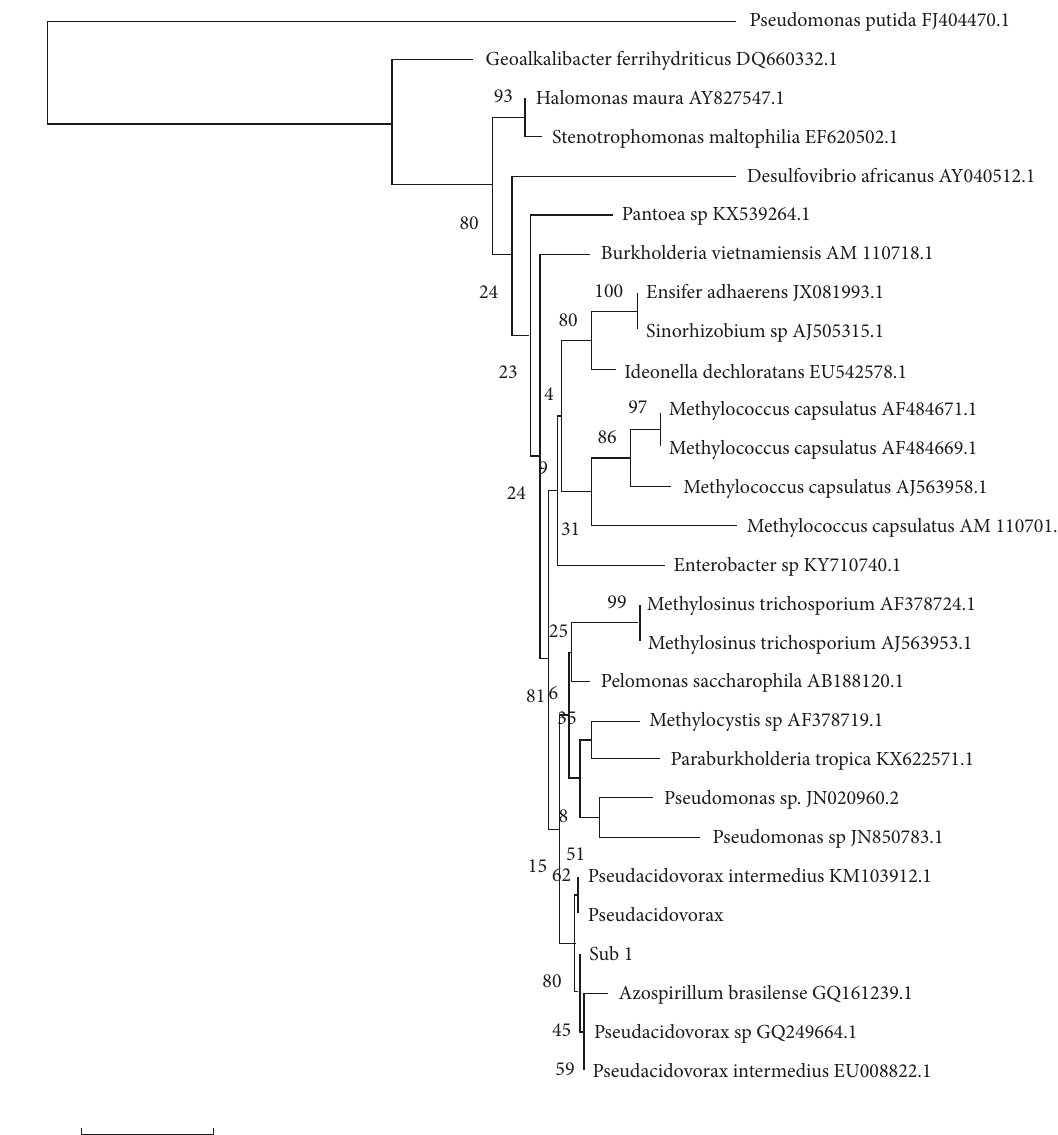
Pueraria plants. Supplementary Figure 2(b): two negative controls of Sub1 with no visible nodules (above). Supplemen- tary Figure 3: negative controls for proline plates to assess swarming motility by Sub1. Supplementary Figure 4: Sub1 infected plants (top) and control plants (bottom), showing differences in shoot length at week 5 after reinfection. Sup- plementary Figure 5: the negative control showing no biofilm formation. Biofilm formation by Sub1 is shown in Figure 4. Supplementary Table 1: statistical analysis on root lengths of the plants. Supplementary Table 2: statistical analysis of shoot lengths in plants. (Supplementary